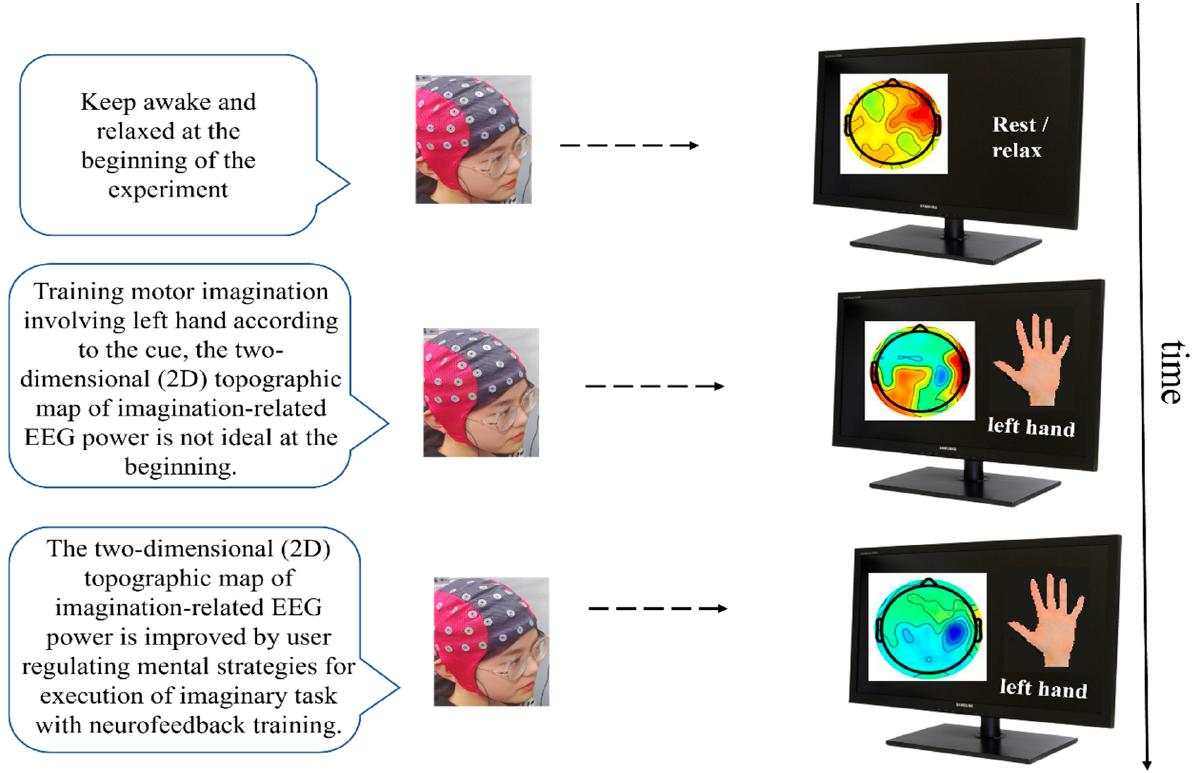
Figure 3. Way of providing visual feedback to users to make them adjust their mental tasks in a timely